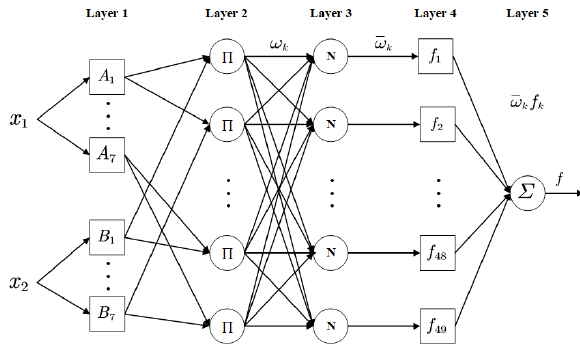
Figure 8. Structure of ANFIS with two inputs, one output .